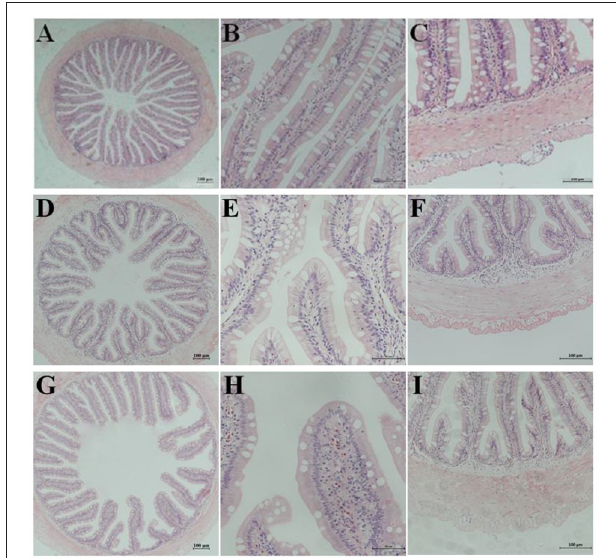
FIGURE 1 | Hematoxylin-eosin staining in the hindgut of pearl gentian grouper. Representative histomorphological images from hematoxylin and eosin stain ed sections of distal intestine of grouper juvenile depicting the inflammatory changes in grouper fed the FM (A–C) , FSBM20 (D–F) , and FSBM40 (G–I) diets. (A,D,G) Representative images of decreased height and increased fusion of the mucosal folds in FSB M20 and FSBM40 group. (B,E,H) Representative images of increased width and cellular (leucocyte) infiltration (asterisk) of the lamina propria (arrows) in FSBM20 and FSBM40 group. (C,F,I) Representative images of increased width and cellular (leucocyte) infiltration of the submucosa. FM, fish meal control group; FSBM20, 20% FSBM protein